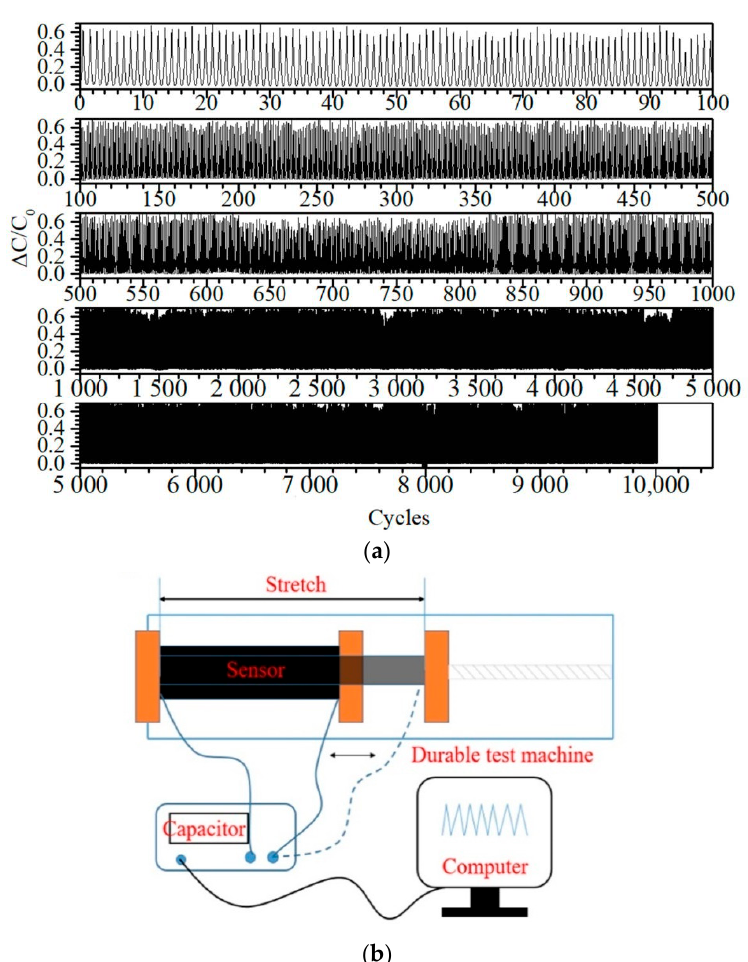
Figure 4. ( a ) Signal traces from tensile strain cycling, recorded at a frequency of 0.2 Hz with 40% elongation, and displayed over different periods from this durability test. The cycles shown in descending order are zero to 100, 100 to 500, 500 to 1000, 1000 to 5000, and 5000 to 10,000. ( b ) Schematic of the custom tensile strain cycling test apparatus.